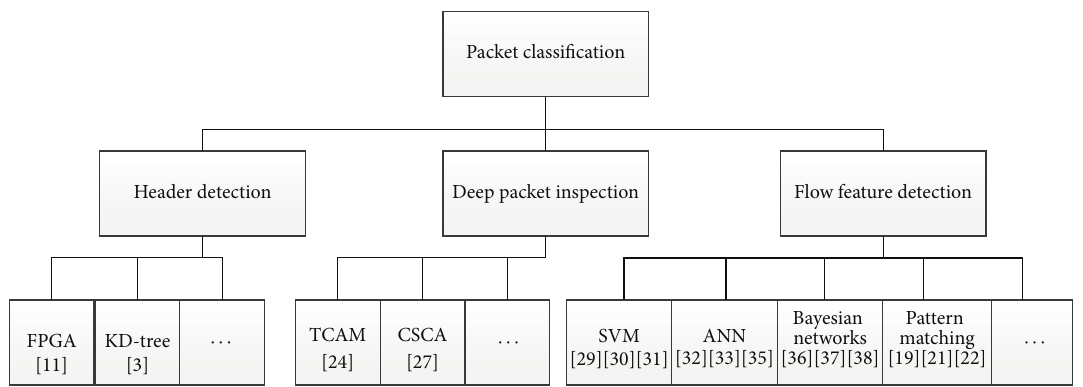
Figure 1: Categories of packet classification